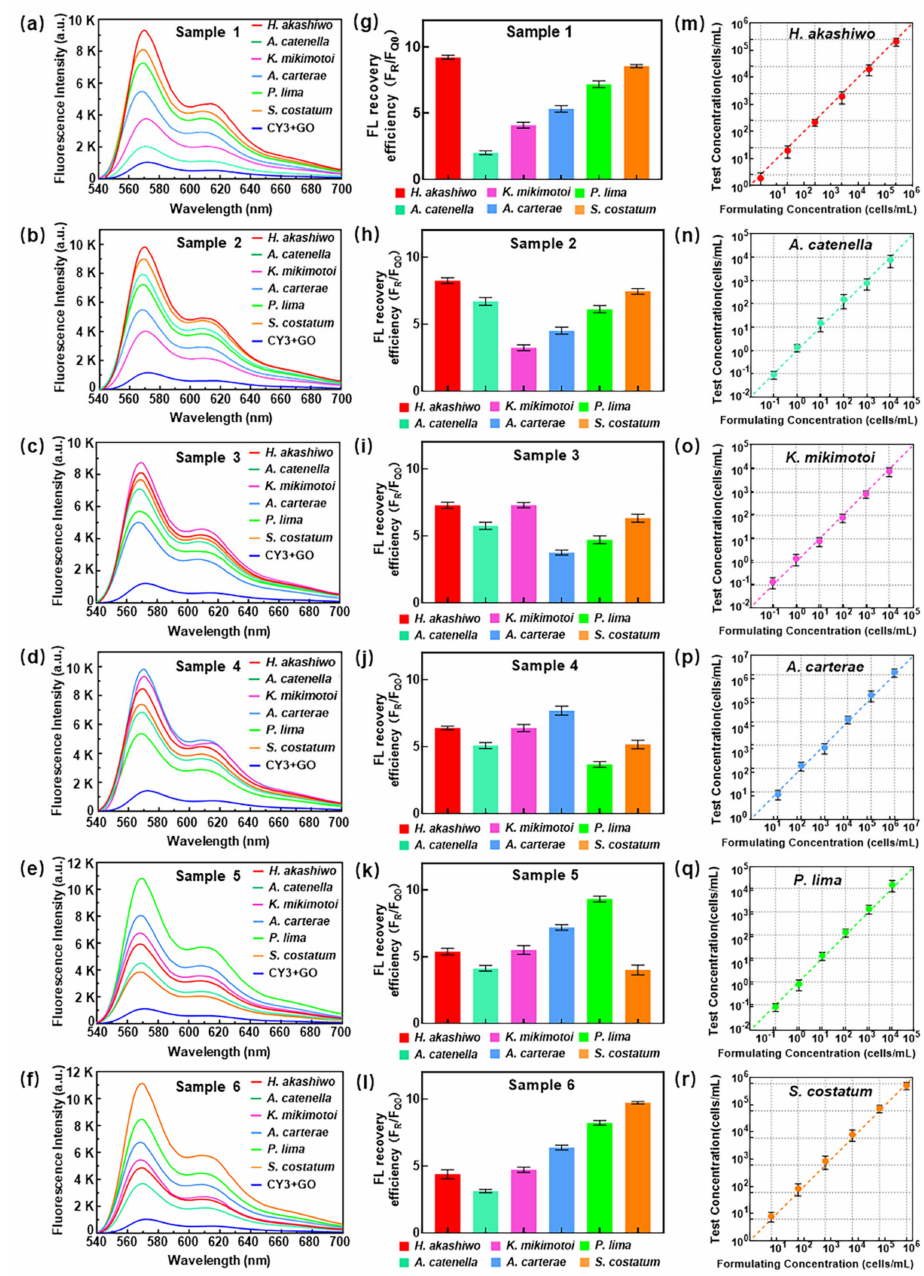
Figure 5. ( a – f ) PL spectrum, ( g – l ) fluorescence recovery efficiency and ( m – r ) the deviation between formulating concentration and test concentration of each